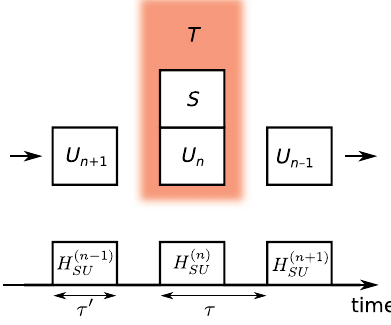
FIG. 2. Sketch of a stream of units interacting with a system in contact with a heat reservoir at inverse temperature β . The lower panel shows the switching on and off of the system-unit interaction as a function of time. Note that τ denotes the full interaction period, whereas the system and unit are only physi- cally coupled during a time τ 0